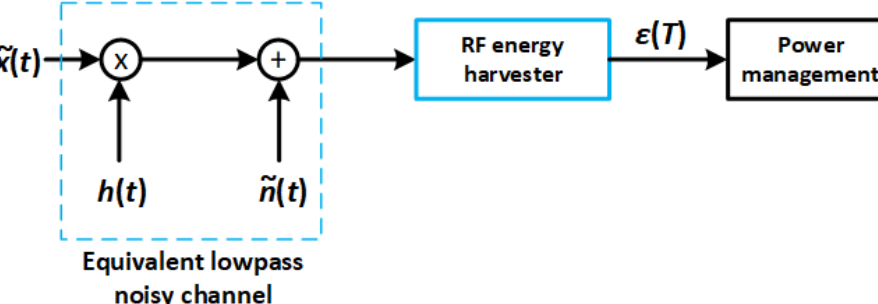
Figure 5. Equivalent low-pass model of the